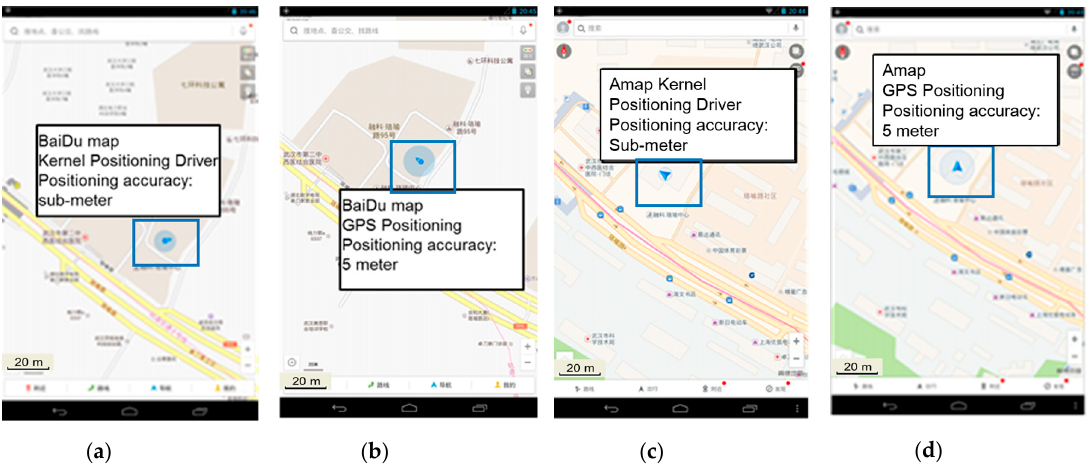
Figure 9. Effect contrast between Baidu Map and AutoNavi with high precision kernel driver and ordinary positioning. ( a ) Baidu Map-high precision kernel driver; ( b ) Baidu Map-GPS positioning; ( c ) AutoNavi-high precision kernel driver; ( d ) AutoNavi Map-GPS positioning.